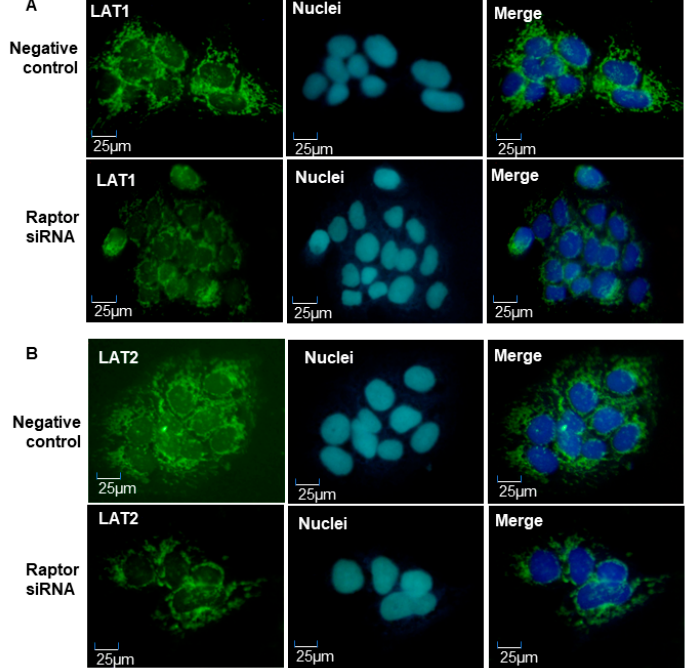
Figure 6. Representative imaging of immunofluorescent staining of LAT1 and LAT2 in JEG-3 trophoblast cells treated with negative or raptor siRNA. ( A ) LAT1 expression; ( B ) LAT2 expression. Consistent with Western blot results, raptor siRNA could reduce LAT1 and LAT2 expression in placental